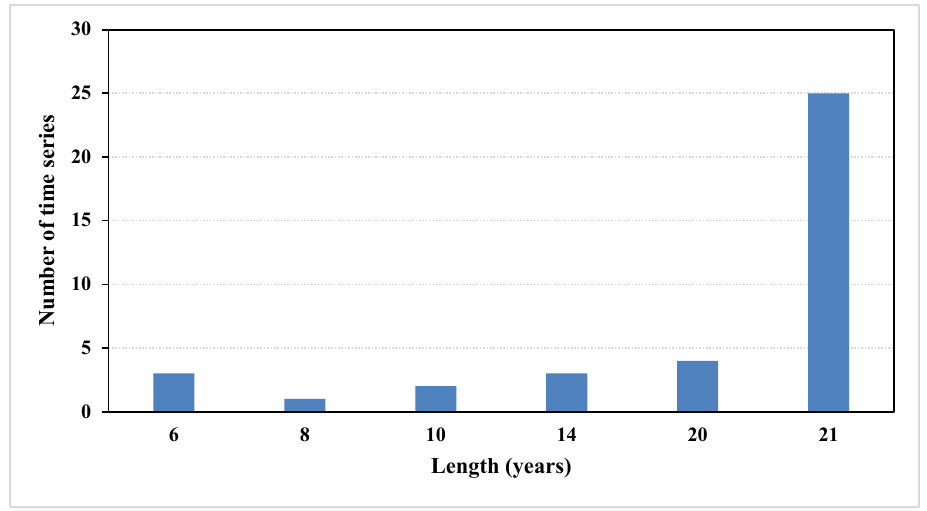
Figure 3. Histograms of lengths of the data series.